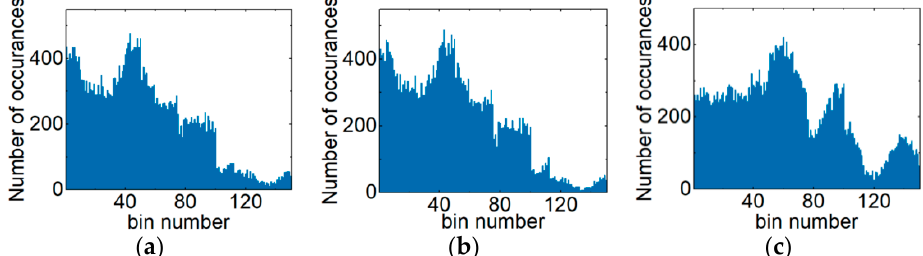
Figure 2. ( a – c ) Constellation diagram of different modulation formats: ( a ) S-16QAM , ( b ) 16QAM and ( c ) 32QAM. ( d )–( f ). ACHs with different modulation formats: ( d ) PDM-S-16QAM, ( e ) PDM- 16QAM and ( f ) PDM-32QAM.